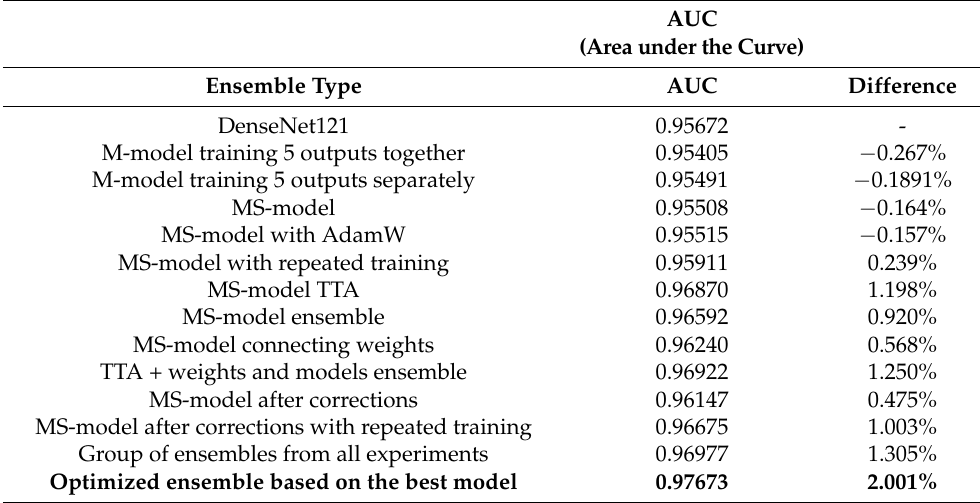
Table 6. Summary of results. The difference column represents the AUC difference between the type and the first starting point in